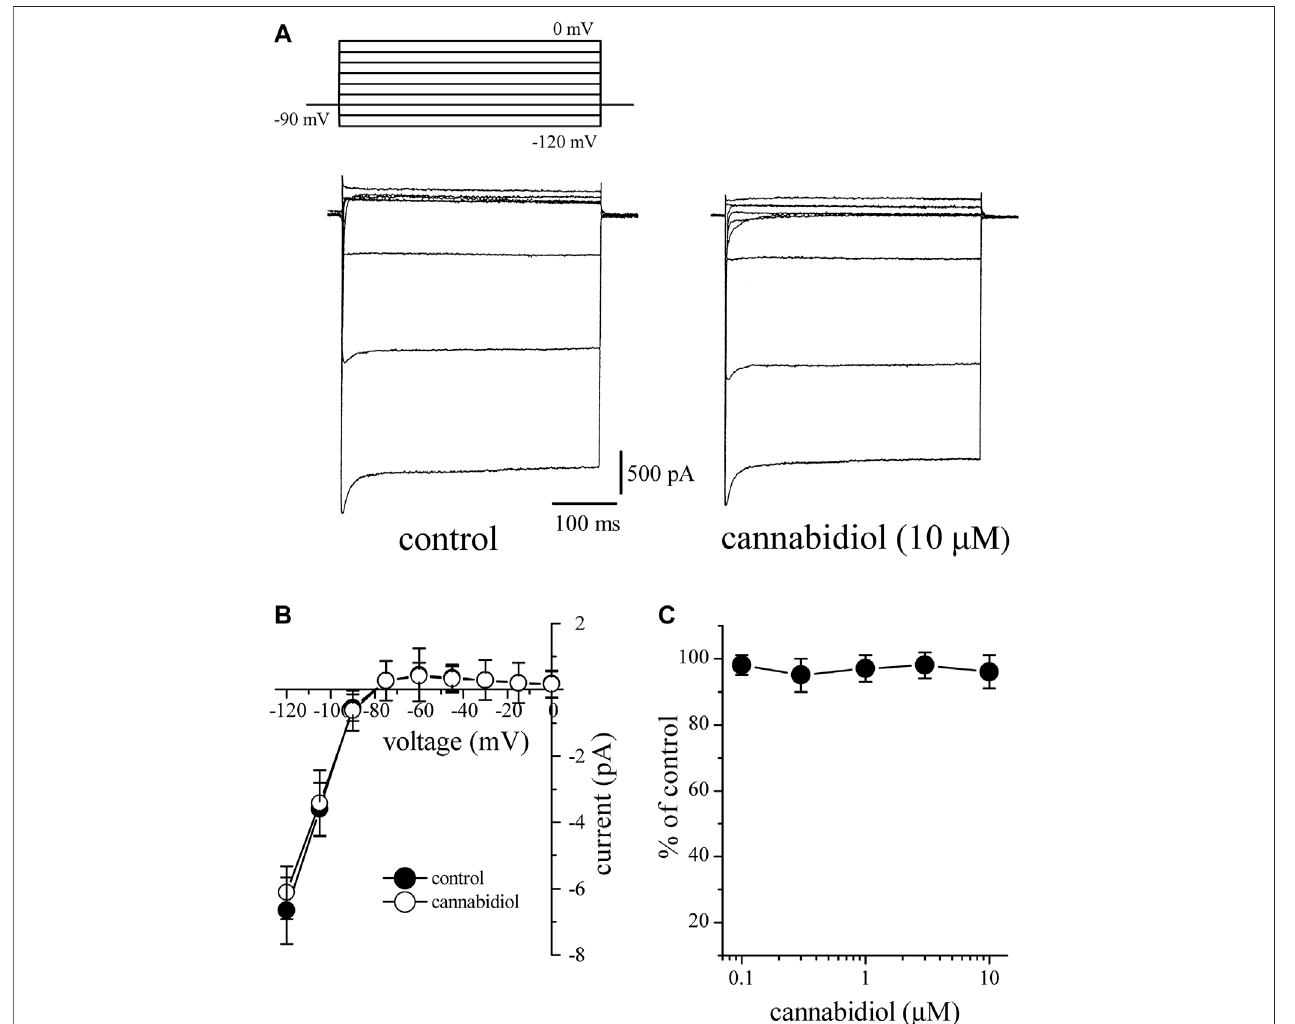
FIGURE 6 | Cannabidiol does not have a signi fi cant effect on I K1 (A) Original current traces recorded in control conditions (on the left) and after10 min exposure to 10 μ M CBD (on the right) in a rabbit cardiomyocyte. The pulse protocol to evoke I K1 is presented in the inset (B) Current-voltage relations of I K1 in the absence and presence of 10 μ M CBD are presented with fi lled and open circles, respectively (n (cid:1) 6) (C) The effect of increasing CBD concentrations on I K1 (n (cid:1) 4 – 6).